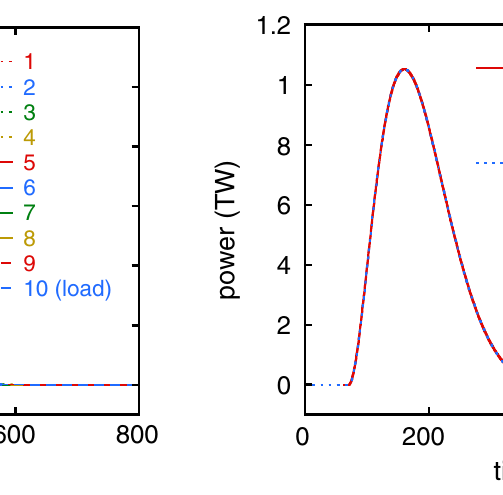
FIG. 8. Simulated electrical-power time histories generated by one of the stages of the IMG illustrated by Fig. 4, and the ten- stage IMG. The power generated by a single stage is that which would be delivered by the stage to a matched-impedance load; i.e., a load with impedance Z . The power generated by the ten- s stage IMG is that which would be delivered by the IMG to a matched-impedance load; i.e., a load with impedance Z . IMG